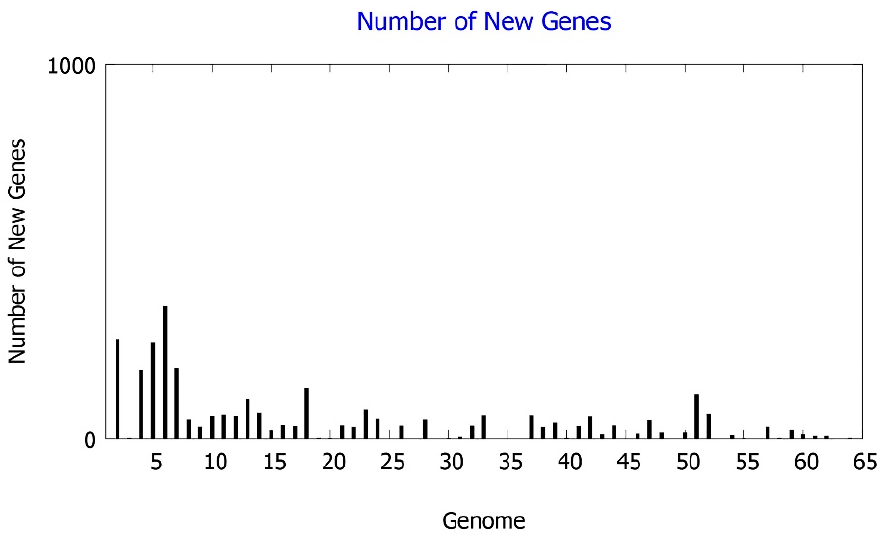
Figure 2. Number of new genes identified in the genomes of the bacteria.